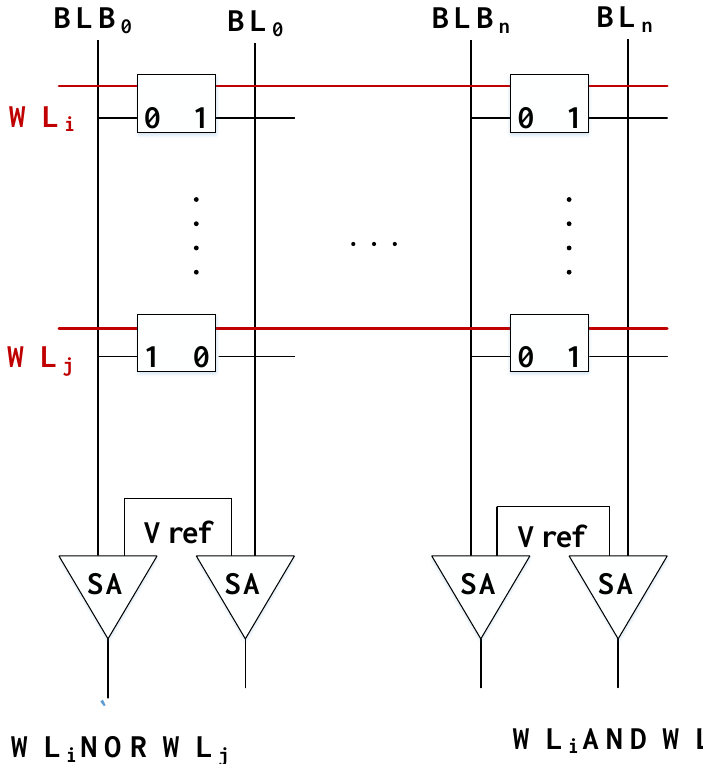
Figure 12. SRAM circuit for bitwise NOR/AND operations (adapted from [48]). An AND operation is performed by sensing BL. A NOR operation can be performed by sensing bitline bar